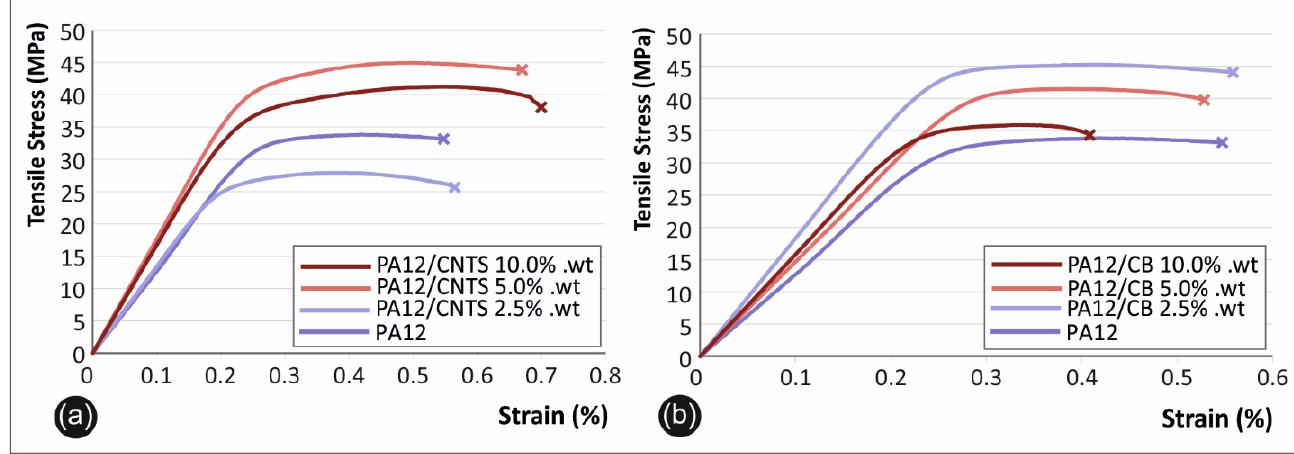
Figure 8. Stress–strain curves for ( a ) PA12 and PA12/CNT, as well as ( b ) PA12 and PA12/CB nanocomposites.